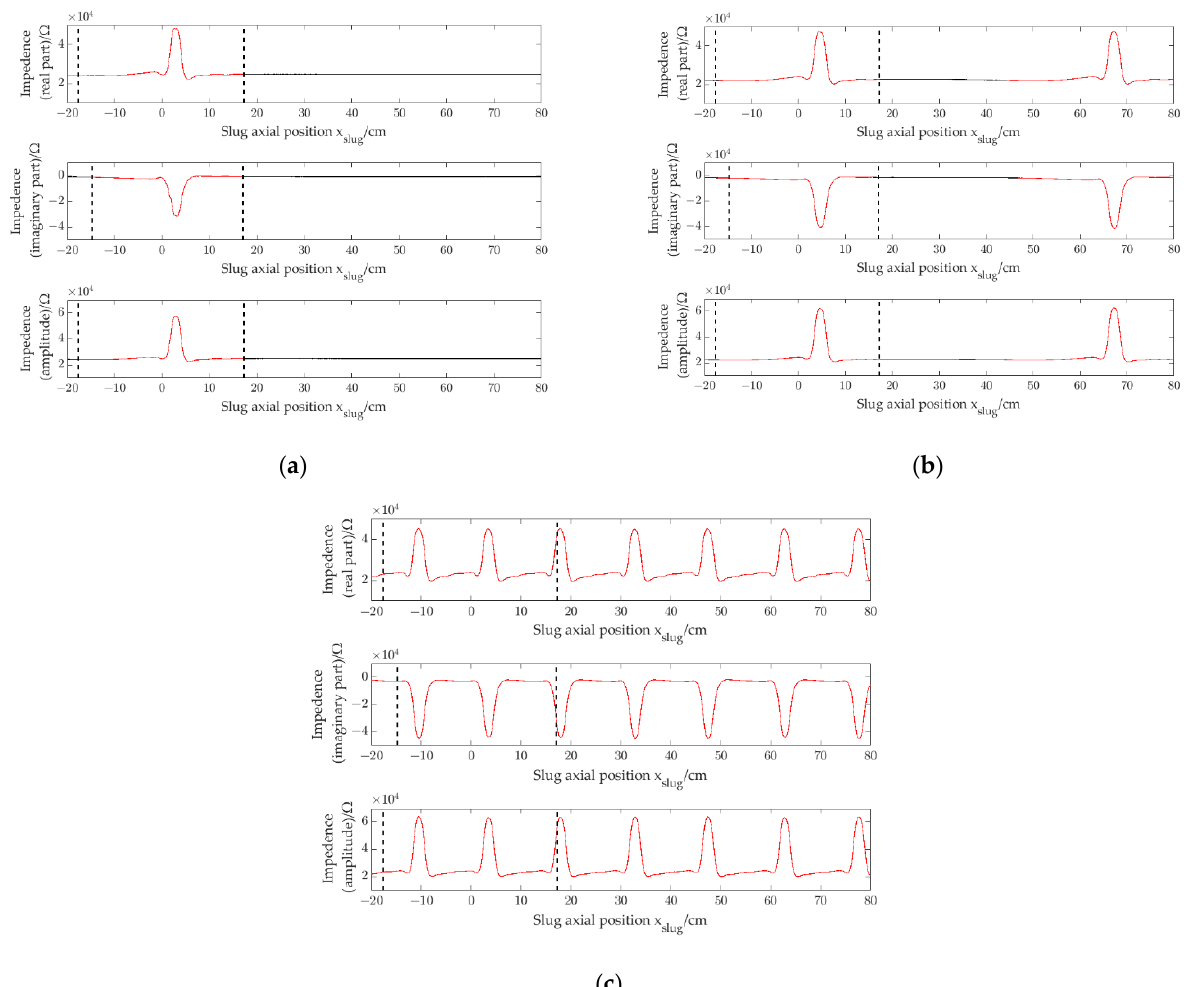
Figure 9. Impedance signals of slug flow, i.d. = 3.54 mm: ( a ) single slug; ( b ) signal separation distance is 63 cm; ( c ) signal separation distance is 14 cm.